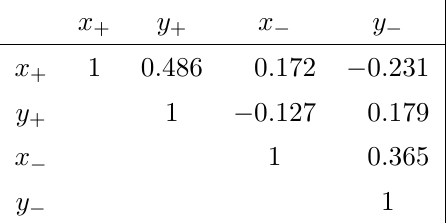
Table 8 . Statistical correlation matrix for ( x + ; y + ; x (cid:0) ; y (cid:0) ) measured from the B (cid:6) ! DK (cid:6) data